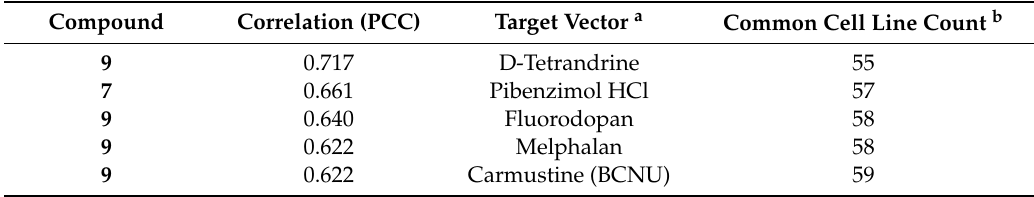
Table 2. Pearson Correlation Coe ffi cient of Selected Compounds with Target Vector and Common Cell Line